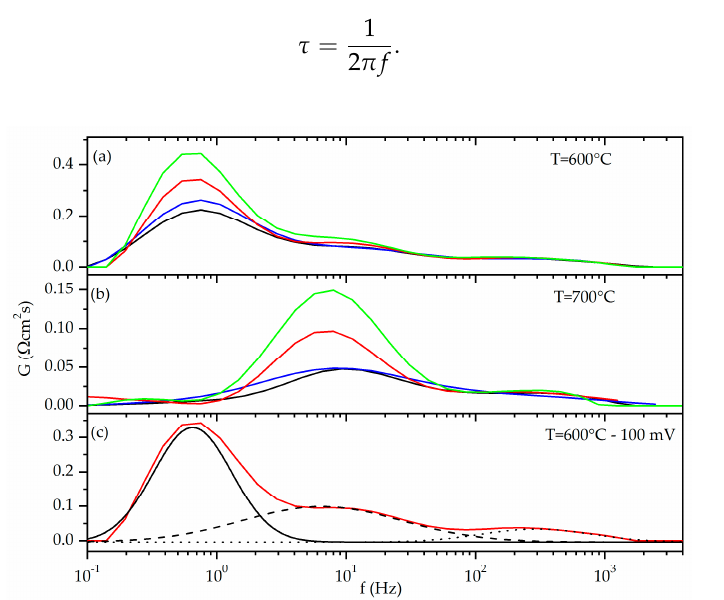
Figure 4. Distribution of relaxation times of BSCF at 600 ( a ) and 700 °C ( b ) for various cathodic bias levels: black = 0 V, blue = 0.05 V, red = 0.1 V and green = 0.2 V. Distribution of relaxation times (solid red line) and Gaussian model (black solid and dashed lines) utilized for RT calculations ( c ).